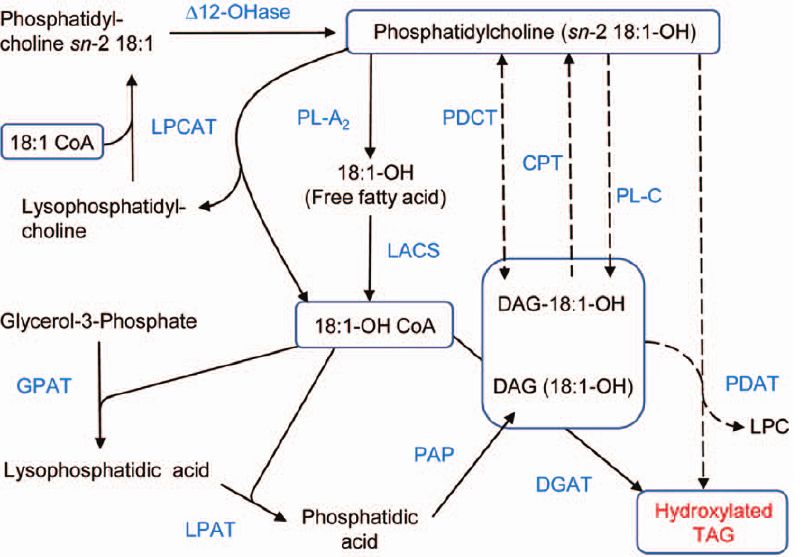
Figure 1. Pathways of triacylglycerol biosynthesis. Reactions in the formation of hydroxylated TAGs via the acyl-CoA dependent (solid arrows) and independent (dashed arrows) pathways are shown. Lipid substrates are abbreviated: 18:1, oleic acid; 18:1-OH, ricinoleic acid; LPC, lysophosphatidylcholine; DAG, diacylglycerol. Enzyme abbreviations are: D 12-OHase, oleate-12-hydroxylase; LPCAT, 1-acylglycerol-3-phosphocholine acyltransferase; PL-A 2 , phospholipase A 2 ; LACS, long chain acyl-CoA synthetase; GPAT, glycerol-3-phosphate acyltransferase; LPAT, lysophosphatidic acid acyltransferase; PAP, phosphatidic acid phosphatase; DGAT, diacylglycerol acyltransferase; CPT, CDP-choline:diacylglycerol cholinepho- sphotransferase; PL-C, phospholipase C; PDAT, phosphatidylcholine diacylglycerol acyltransferase.